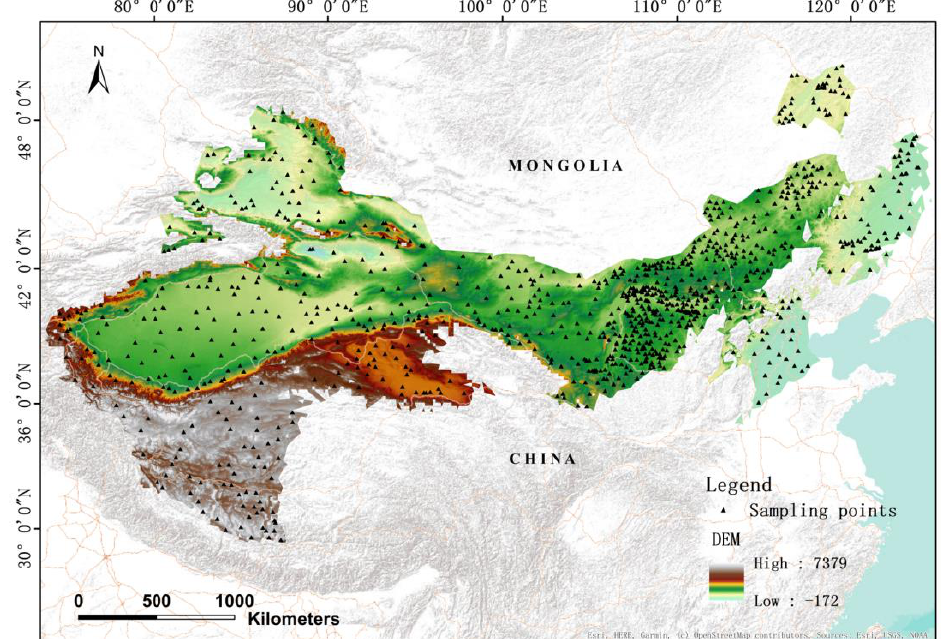
Figure 4. Distribution of sample points. Within the study area, 1000 sample points were selected and distributed as evenly as possible. DEM is the digital elevation model.